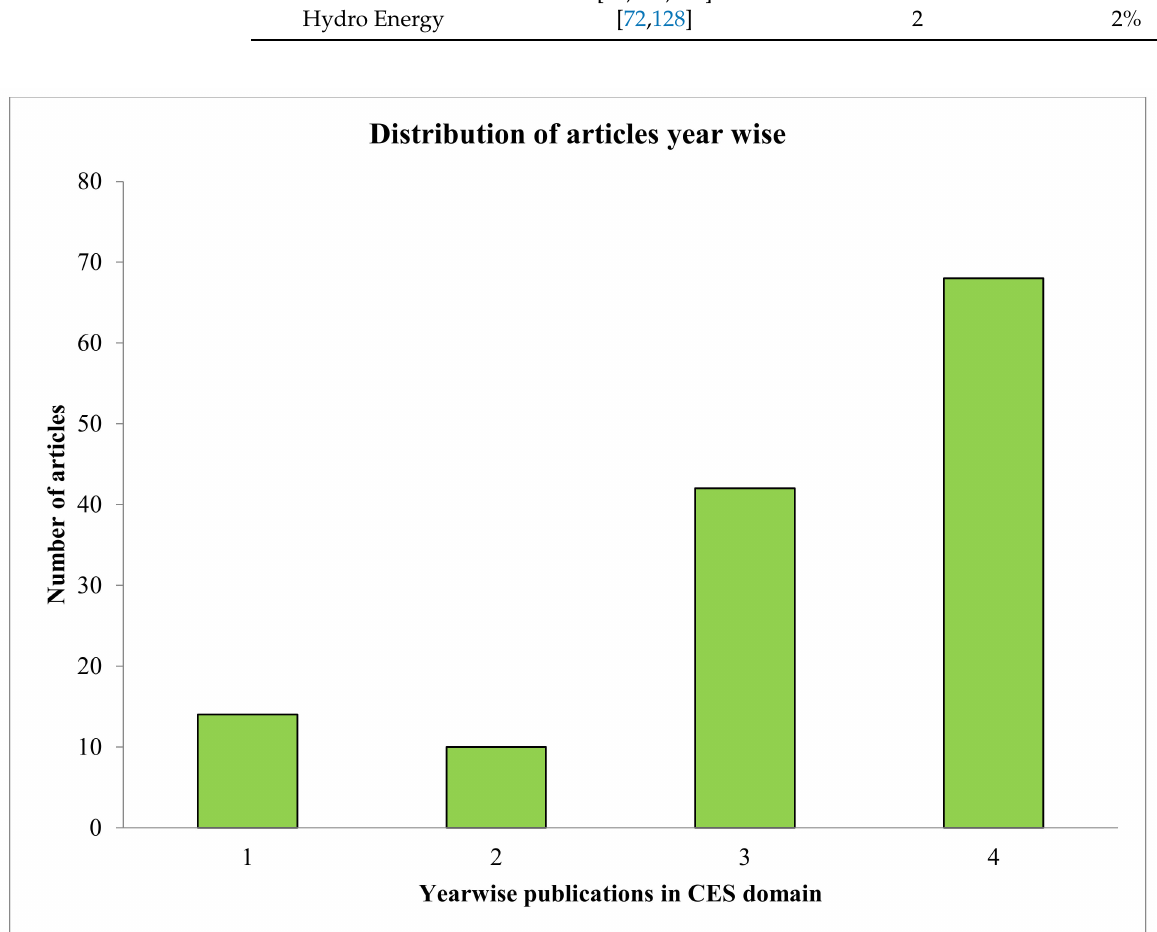
Figure 2. Year-wise publications of articles ( X -axis—1 is 2018, 2 is 2019, 3 is 2020, 4 is